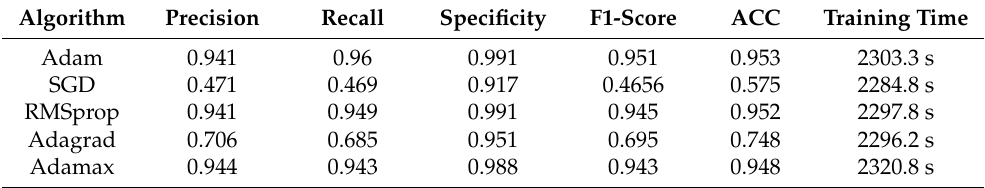
Table 1. Comparison of different optimization algorithms for FERDERnet.